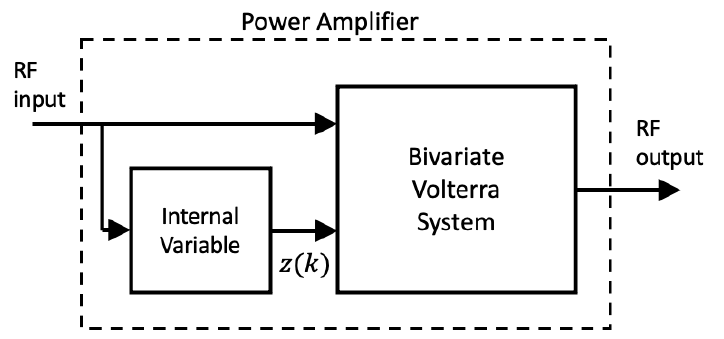
Figure 2. A bivariate Volterra approach to PAs with an internal variable